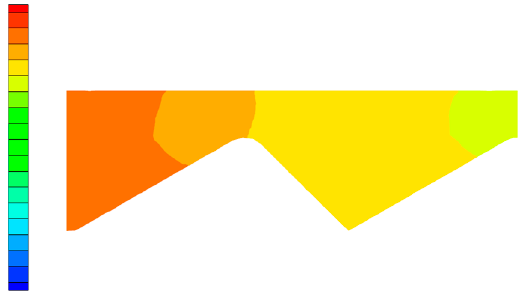
Figure 8. Laminar flow pressure nephogram.